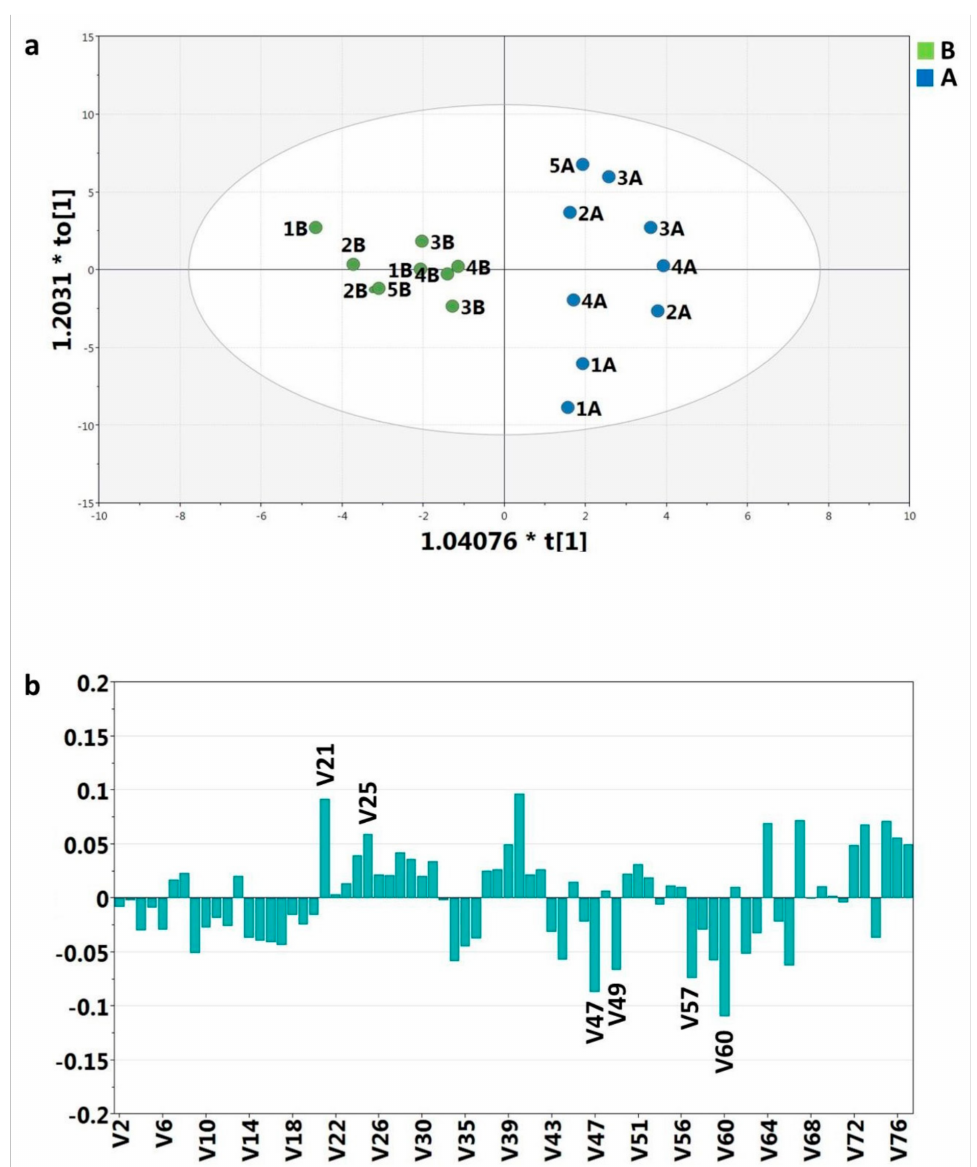
Figure 2. ( a ) Orthogonal partial least-squares-discriminant analysis (OPLS-DA) scores plot. Postprandial urines with (A) and without (B) blueberries of five patients two and four hours after intake. R 2 X cum = 0.304 (fraction of variance cumulative in the X matrix), R 2 Y cum = 1.0 (fraction of cumulative variance in the Y matrix); ( b ) coe ffi cients plot of the 75 variables from 1 H-NMR